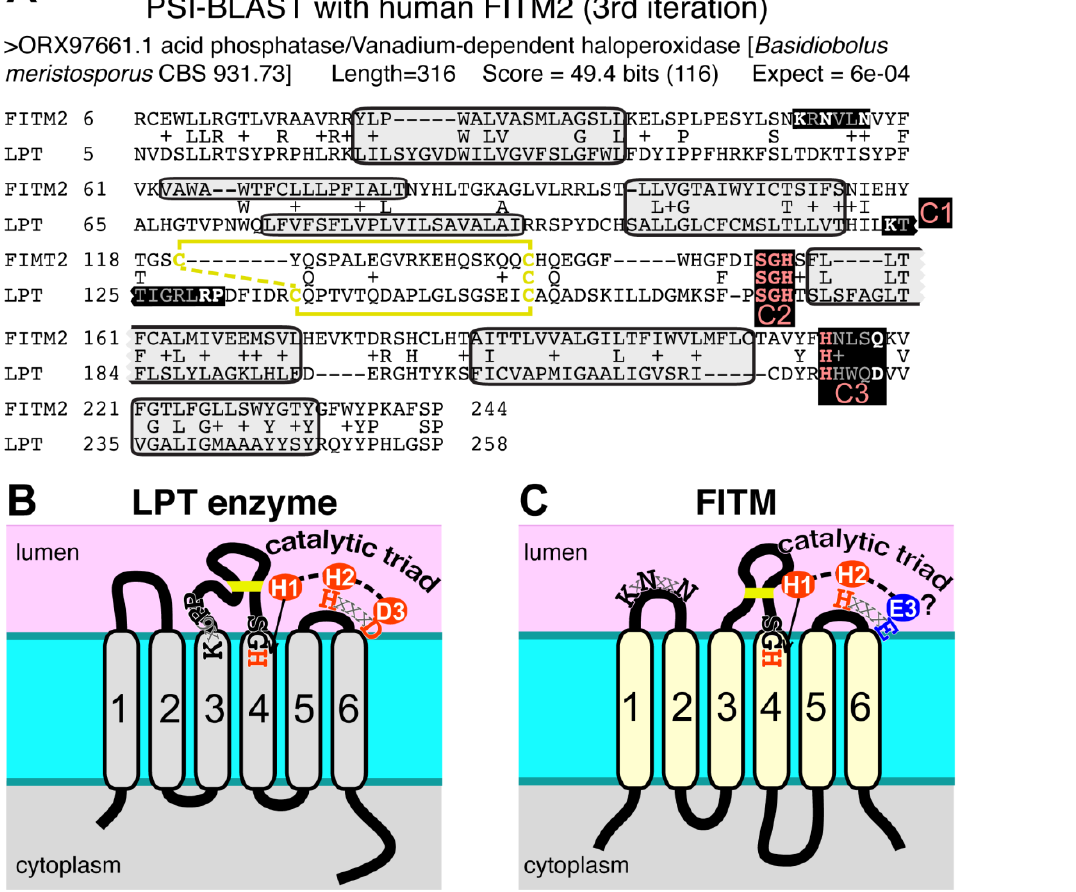
FIGURE 5: FITM proteins are related to lipid phosphatase/phosphotransferase (LPT) enzymes. (A) The final significant hit (number 402) from PSI-BLAST with FITM2 after three iterations using the “nr50” database is a fungal LPT annotated as an acid phosphatase. The con- served residues of LPTs occur in three conserved motifs (C1 C2 C3) that are highlighted and colour coded: pink where precisely shared with FITM2 (C2: SGH , C3: H xxxD/E), white where not shared (C1: K -x6- RP in LPT only; K x N xx N in FITM2 only; C3: Hxxx D/E ). Variable positions within motifs are shown in gray. Predicted transmembrane domains (TMDs, shaded in light gray) align well in five cases. Paired cysteines likely to form a disulphide bridge in the loop between TMD3 and TMD4 are shown in yellow. (B) Topology of a typical LPT enzyme, Dpp1p in yeast, with the three conserved motifs, within which the catalytic triad of the most invariant residues are shown in red. (C) Topology of human FITM2, with the two motifs shared with LPTs and the KxNxxN motif. Residues that align with the catalytic triad are coloured red where identical with LPTs, and blue where